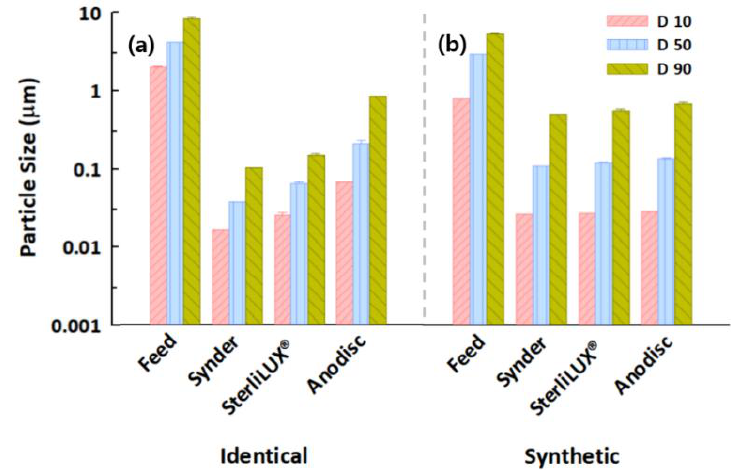
Figure 10. Particle size distribution in the feed and permeate water samples after membrane filtration with the diameter values of the (a) identical and (b) synthetic wastewater for the 1.0 μm PE microplastics.